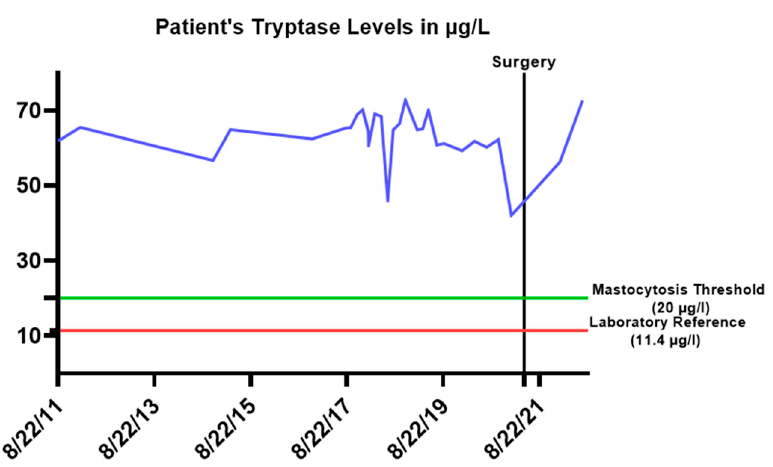
Figure 1. The patient’s tryptase levels were measured from 2011 to 2022 (blue line). As shown, the follow-up levels of the patient were elevated all along the treatment since the first diagnosis date in 2011. The laboratory reference level was 11.4